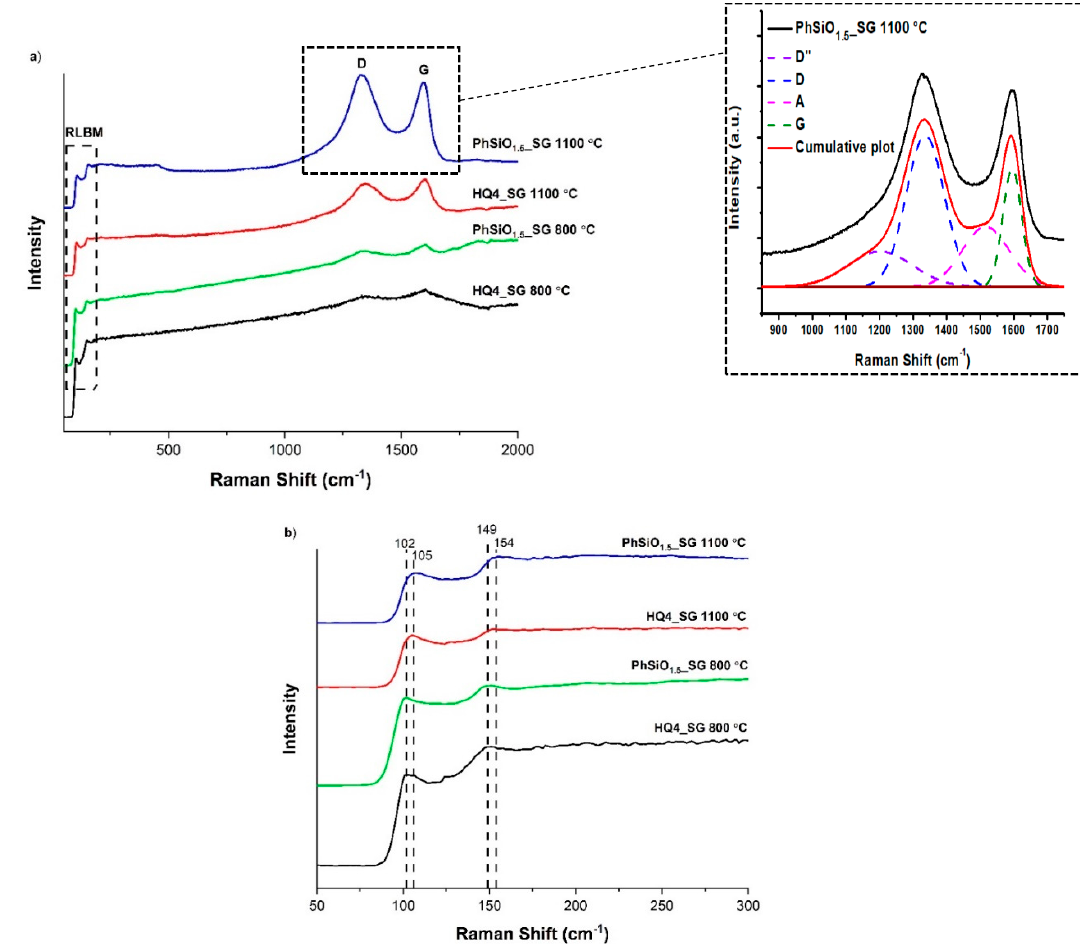
Figure 9. Raman spectra of PhSiO 1.5 _SG and HQ4_SG samples. ( a ) The entire spectra from 50 to 2000 cm − 1 with inset showing the Raman fitting of PhSiO 1.5 _SG 1100 °C and ( b ) the spectra from 50 to 300 cm − 1 to show details of the RLBM bands.